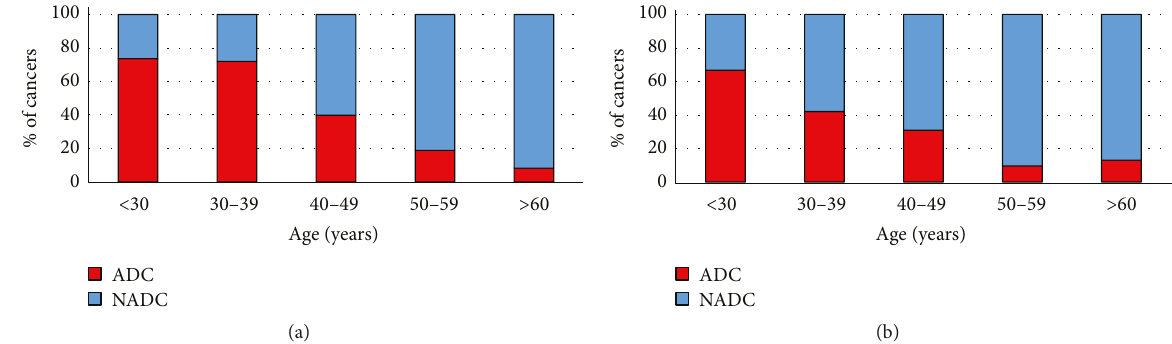
Figure 1: Distribution of AIDS-defining cancers (ADCS) and non-AIDS-defining cancers (NADCs) among men (a) and women